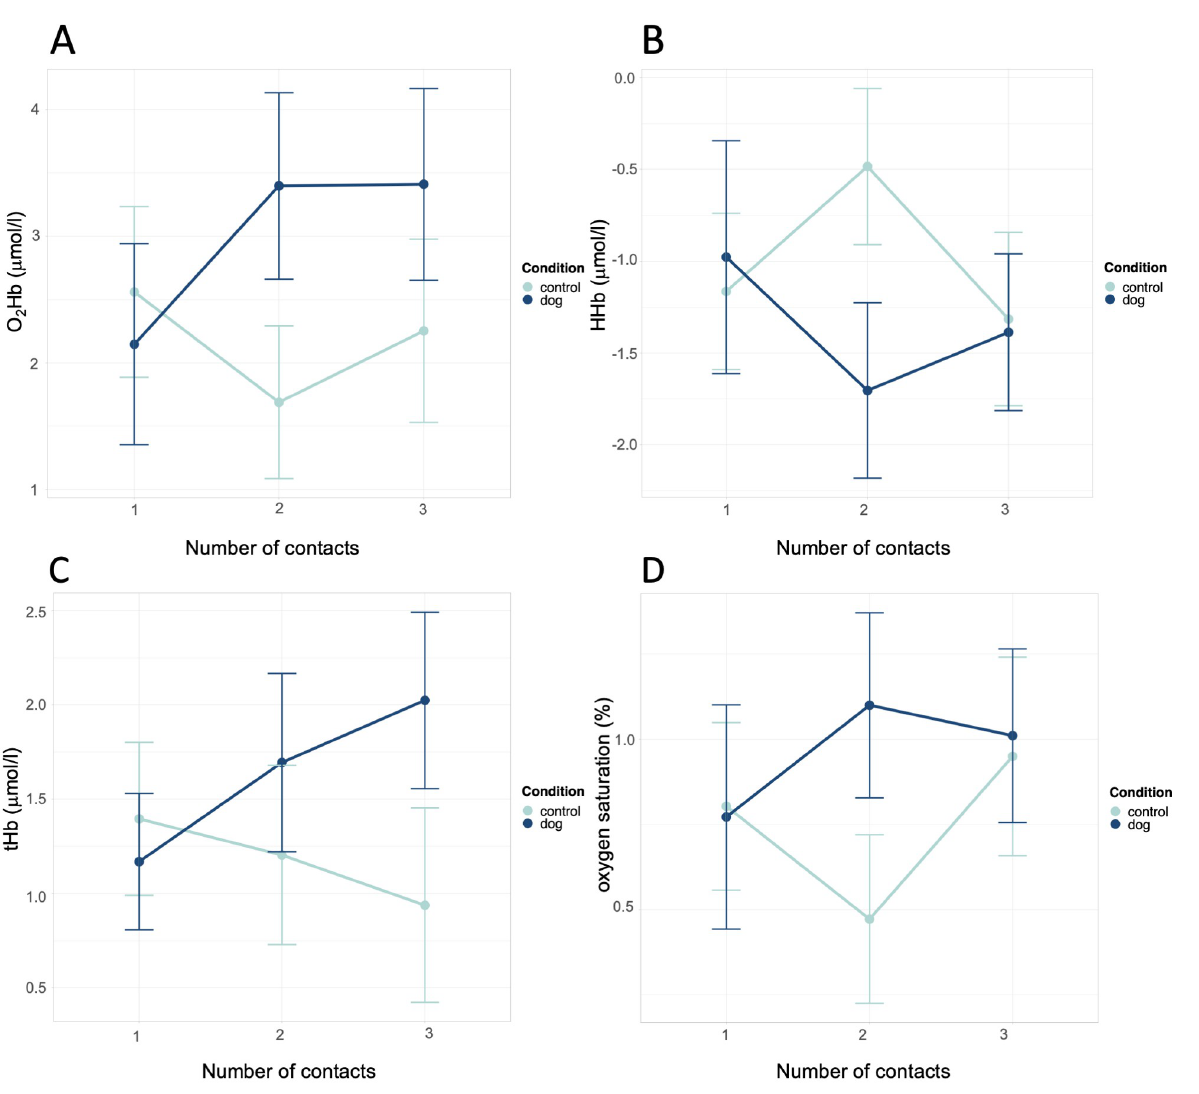
Fig 4. Effects of condition and number of contacts on O 2 Hb, HHb, tHb, and oxygen saturation. (A) O 2 Hb, (B) HHb, (C) tHb, and (D) oxygen saturation. Error bars denote confidence intervals. Data are shown as relative change from phase neutral 1. The data for phase neutral 1 are not included in the presented